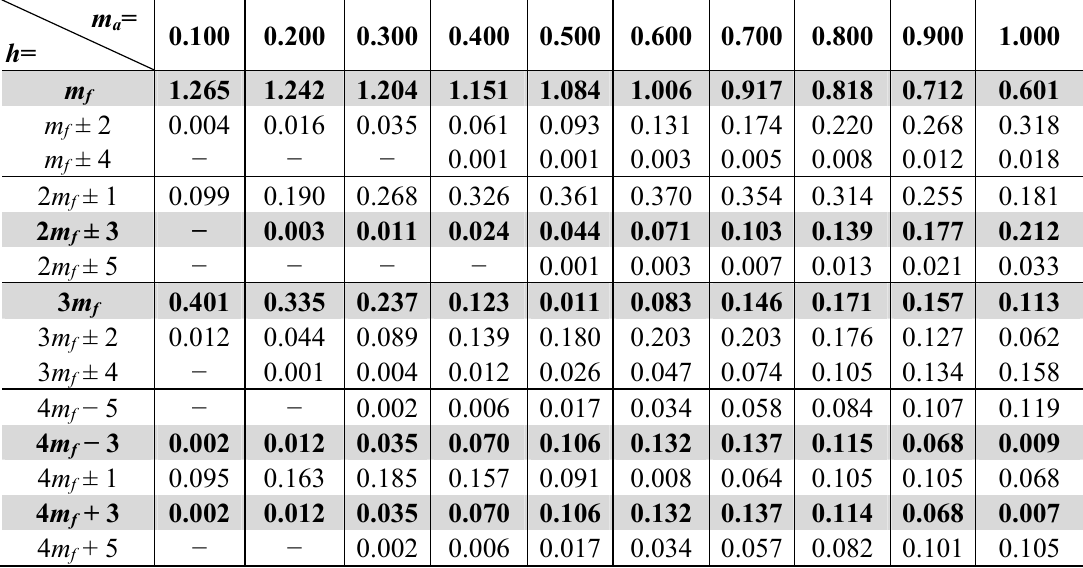
Table 1. Harmonic content h as a function of the amplitude modulation m a and of the frequency modulation m f indexes (greyed rows are absent in three-phase inverters provided m f is a multiple of